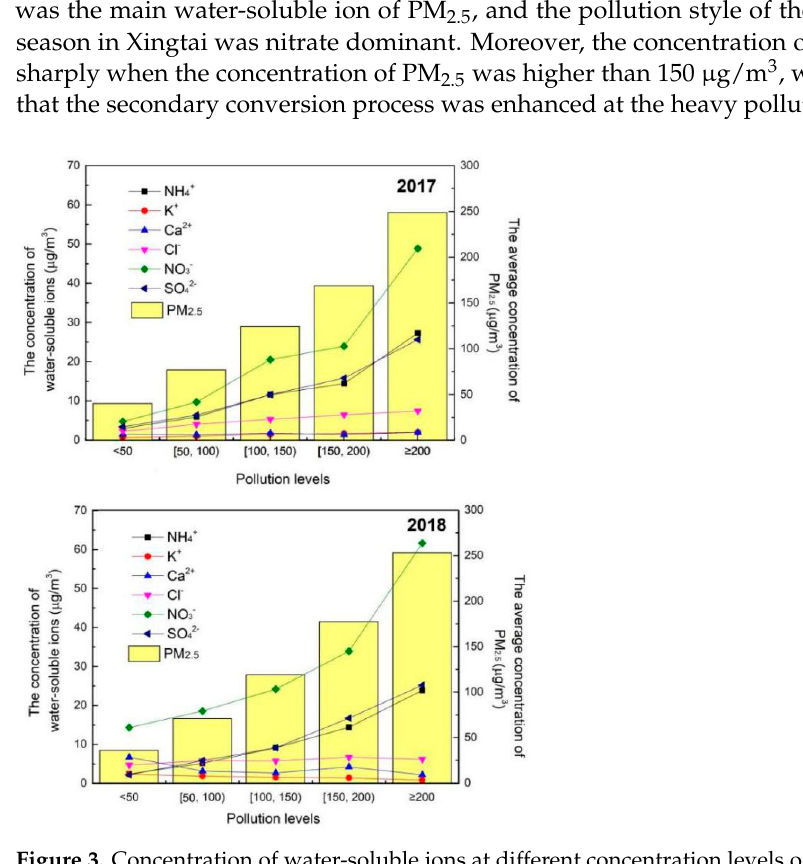
Figure 3. Concentration of water-soluble ions at different concentration levels of PM 2.5. The concentrations of EC, OC, and the concentration ratios of OC/EC, NO 3 − /SO 42 − at different concentration levels of PM 2.5 in the two autumn–winter seasons are shown in Figure 4. With the increase in the PM 2.5 concentration levels, the concentrations of OC and EC all increased. Though the concentrations of OC and EC in the autumn–winter season of 2018–2019 were lower than those of 2017–2018, the concentration ratio of OC/EC in 2018– 2019 was higher than that in 2017–2018, indicating that though the total carbon decreased, the secondary conversion rate increased. OC/EC level was higher at the high concentration level of PM 2.5 , suggesting that chemical conversion was enhanced during high pollution weather. The concentration ratios of NO 3 − /SO 42 − are also shown in Figure 4, which indicates that the concentration ratios of NO 3 − /SO 4 2 − in the autumn–winter season of 2018–2019 were higher than those of 2017–2018, which also proves the importance of NO x pollution